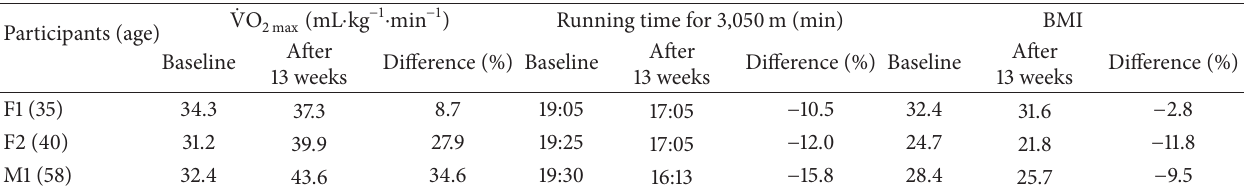
̇ Table 1: Maximum oxygen uptake ( VO 2 max ), running time for 3,050 m test, and body mass index (BMI) at baseline and after 13 weeks of training for the three